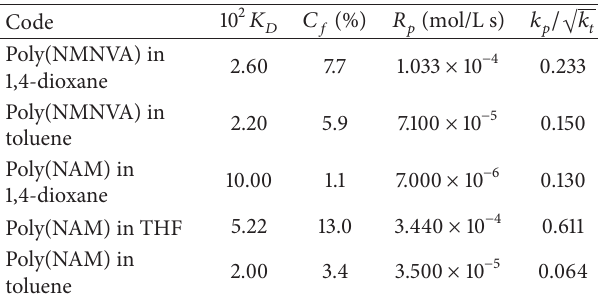
Table 1: Features of dilatometric measurements for poly(NAM) and for